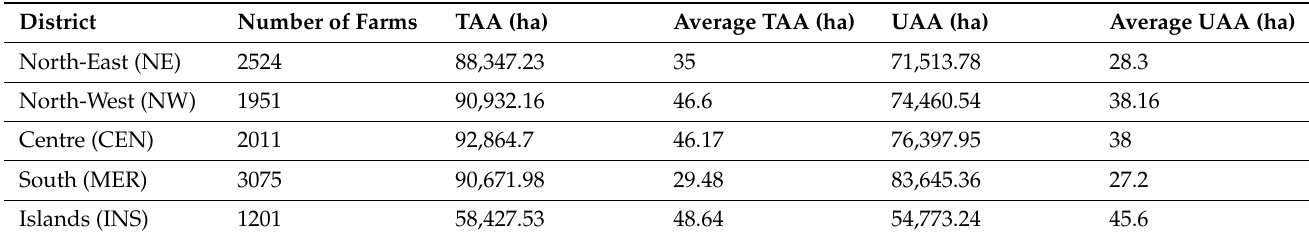
Figure 1. Map of Italian geographical districts. Table 1. Main characteristics of FADN farms in Italian geographical districts.